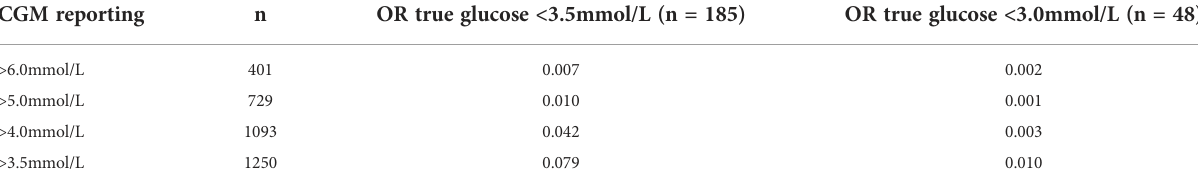
TABLE 2 Odds Ratios (OR) for true (SMBG) hypoglycaemia at various CGM glucose values. n = number.